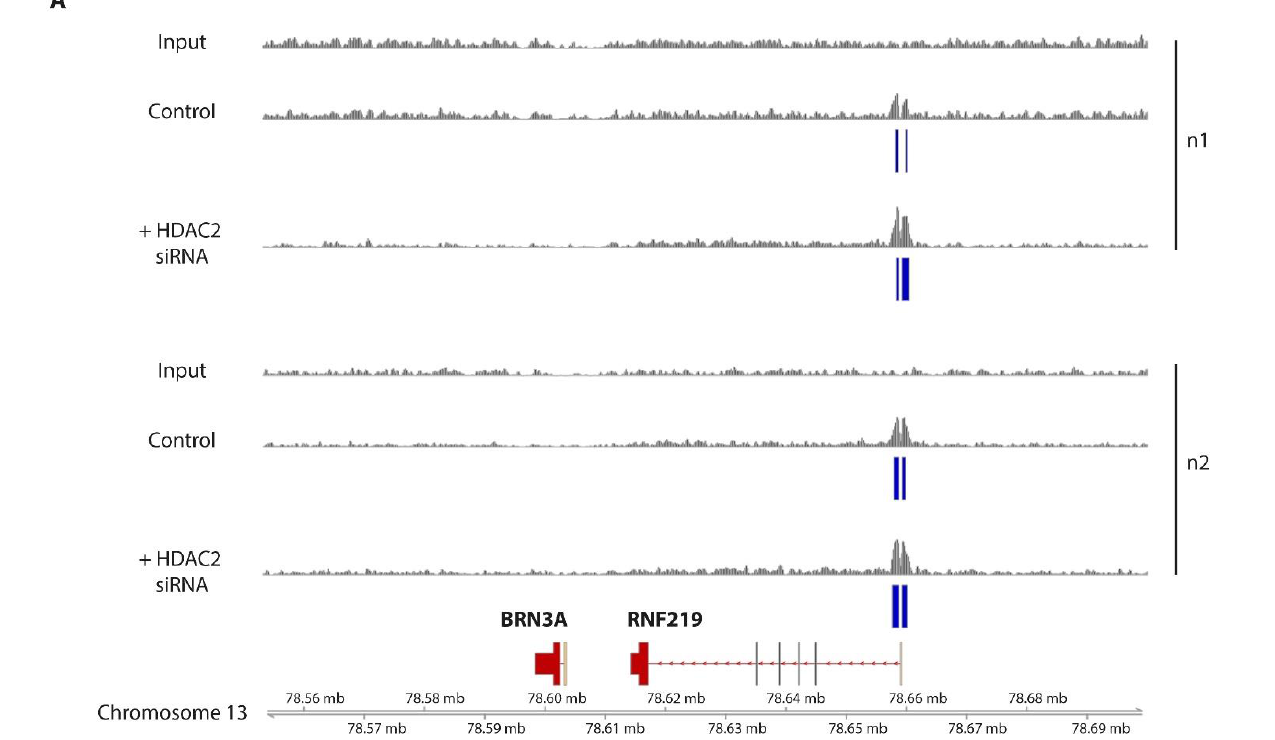
Figure 6. HDAC2 inhibition increases H3K27 acetylation (H3K27ac) status in a distal enhancer ele- ment of BRN3A . ( A ) H3K27 acetylation status of the genetic region chr13:78,550,000 – 78,700,000 (hg38) in WM9 melanoma cells transfected with HDAC2-specific siRNA or control siRNA (control) compared to input. Peaks illustrate the normalized read counts. Blue bars highlight identified peaks with a false discovery rate of 1 × 10 −6 compared to input in the genomic region chr13:78,656,679 – 78,661,679, which is located near to the TSS of the RNF219 gene and annotated as a promoter/en- hancer element of BRN3A in the GeneHancer database (GeneHancer Identifier GH13J078657, https://www.genecards.org/cgi-bin/carddisp.pl?gene=POU4F1, accessed on 18 September 2019